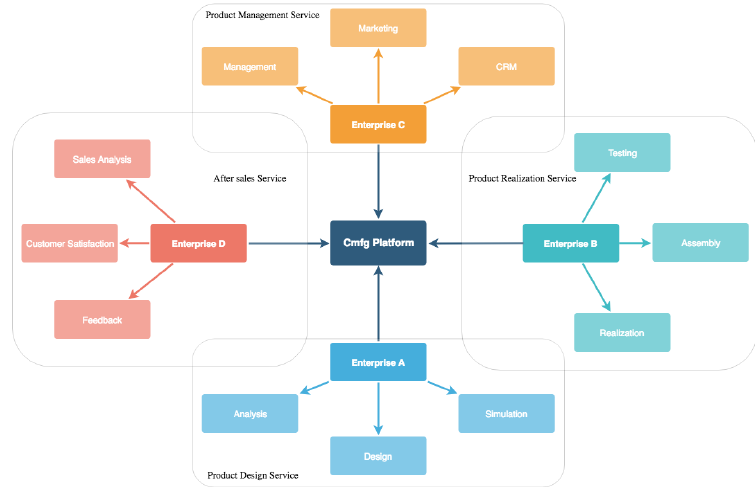
Figure 7. An example of a collaborative network established via a cloud platform.